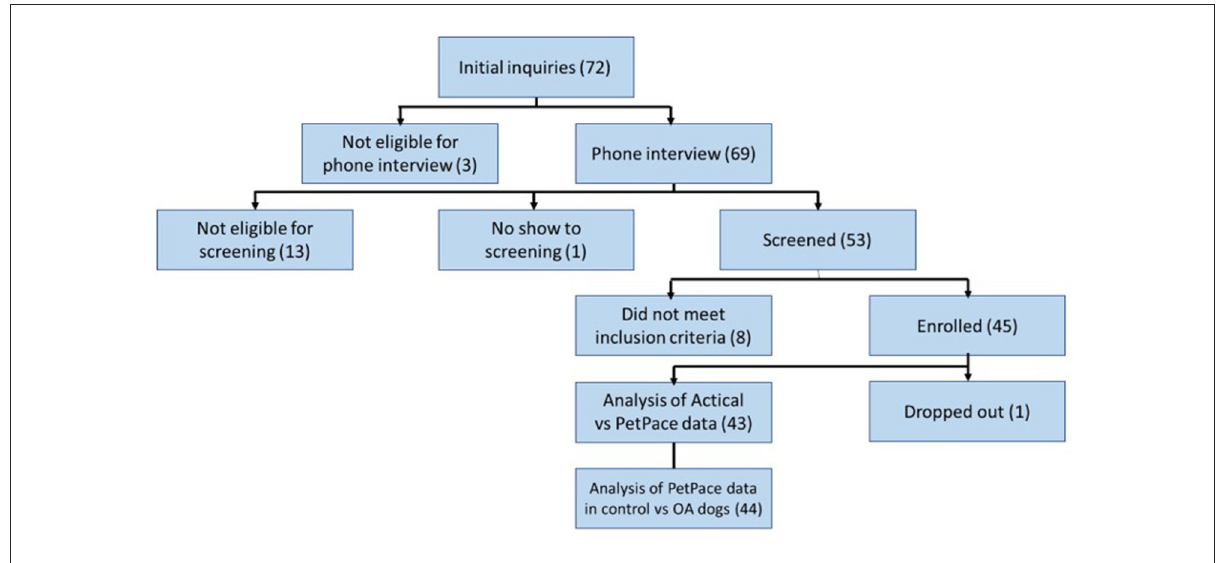
FIGURE3 Study participant flow